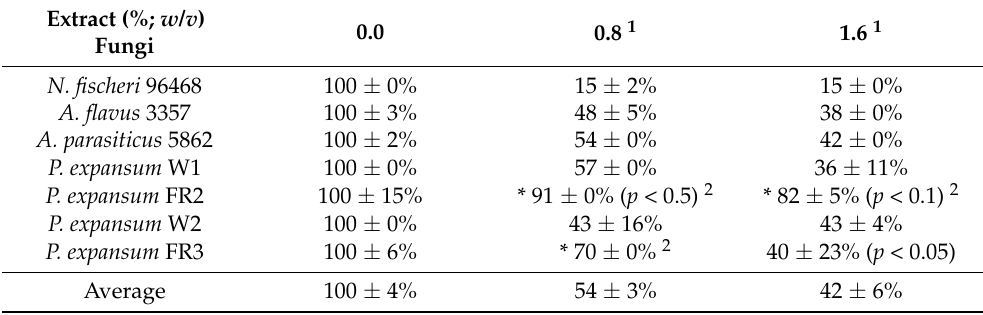
Table 2. Antifungal activity of TcM on PDA (% radial growth compared to no treatment control). Extract (%; w / v